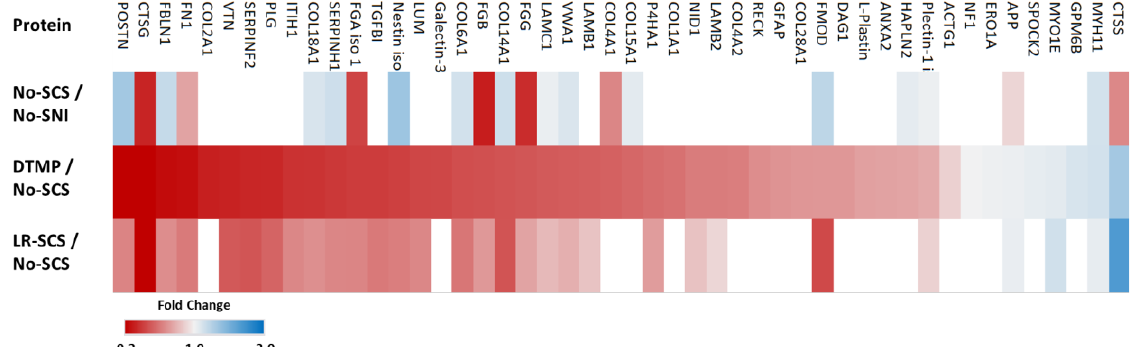
Figure 1. Fold-change (FC) heatmap of the ECM structural proteins (n = 48). Red (decrease) and blue (increase) represent significantly changed expression levels, and white stands for no significant change.